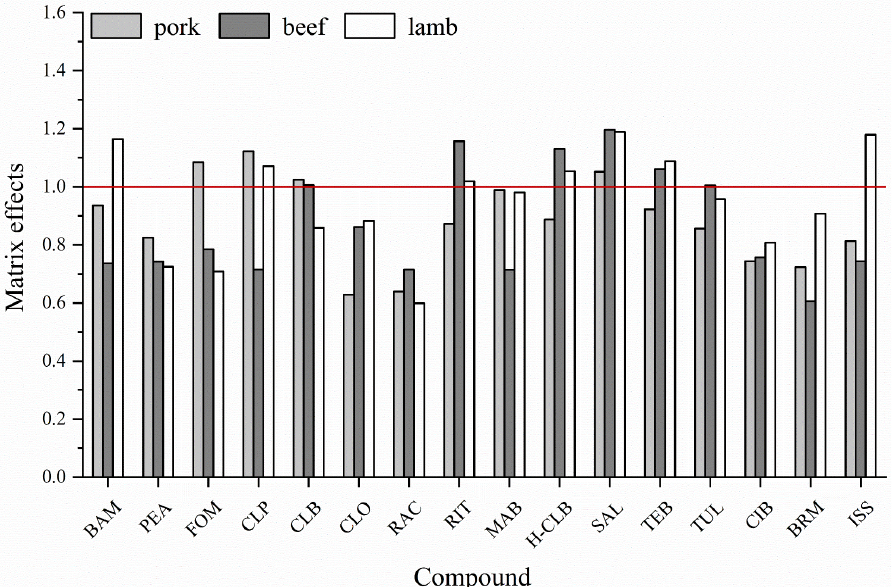
Figure 4. Matrix effects of sixteen β -agonists in three substrates. Values > 1 show matrix enhancement effect, values < 1 show matrix inhibition effect.